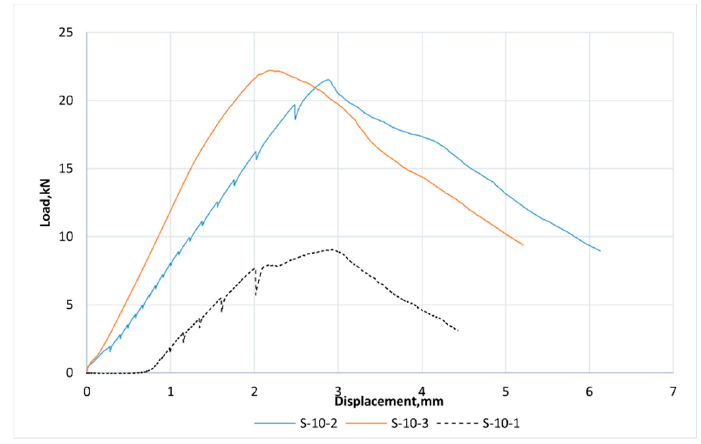
Figure 20 . Load–slip relationship of the 10-mm, 5 d b steel specimens .